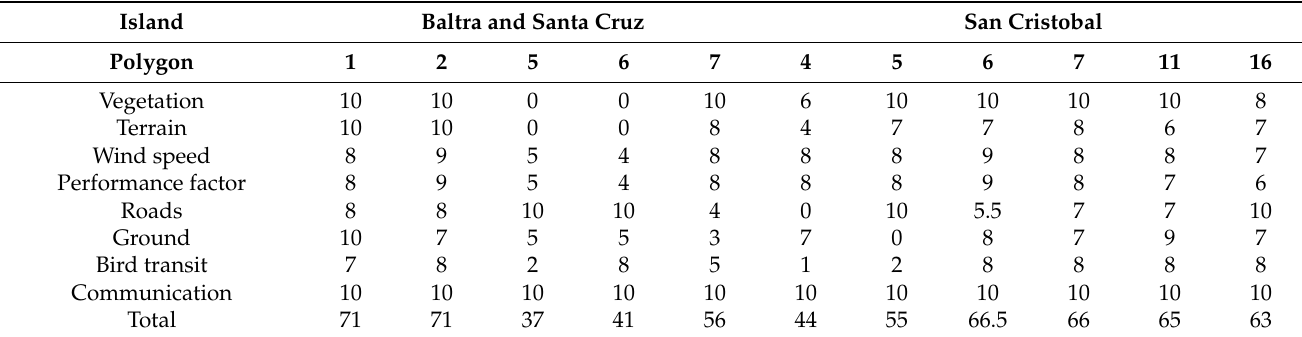
Table 11. Field exploration